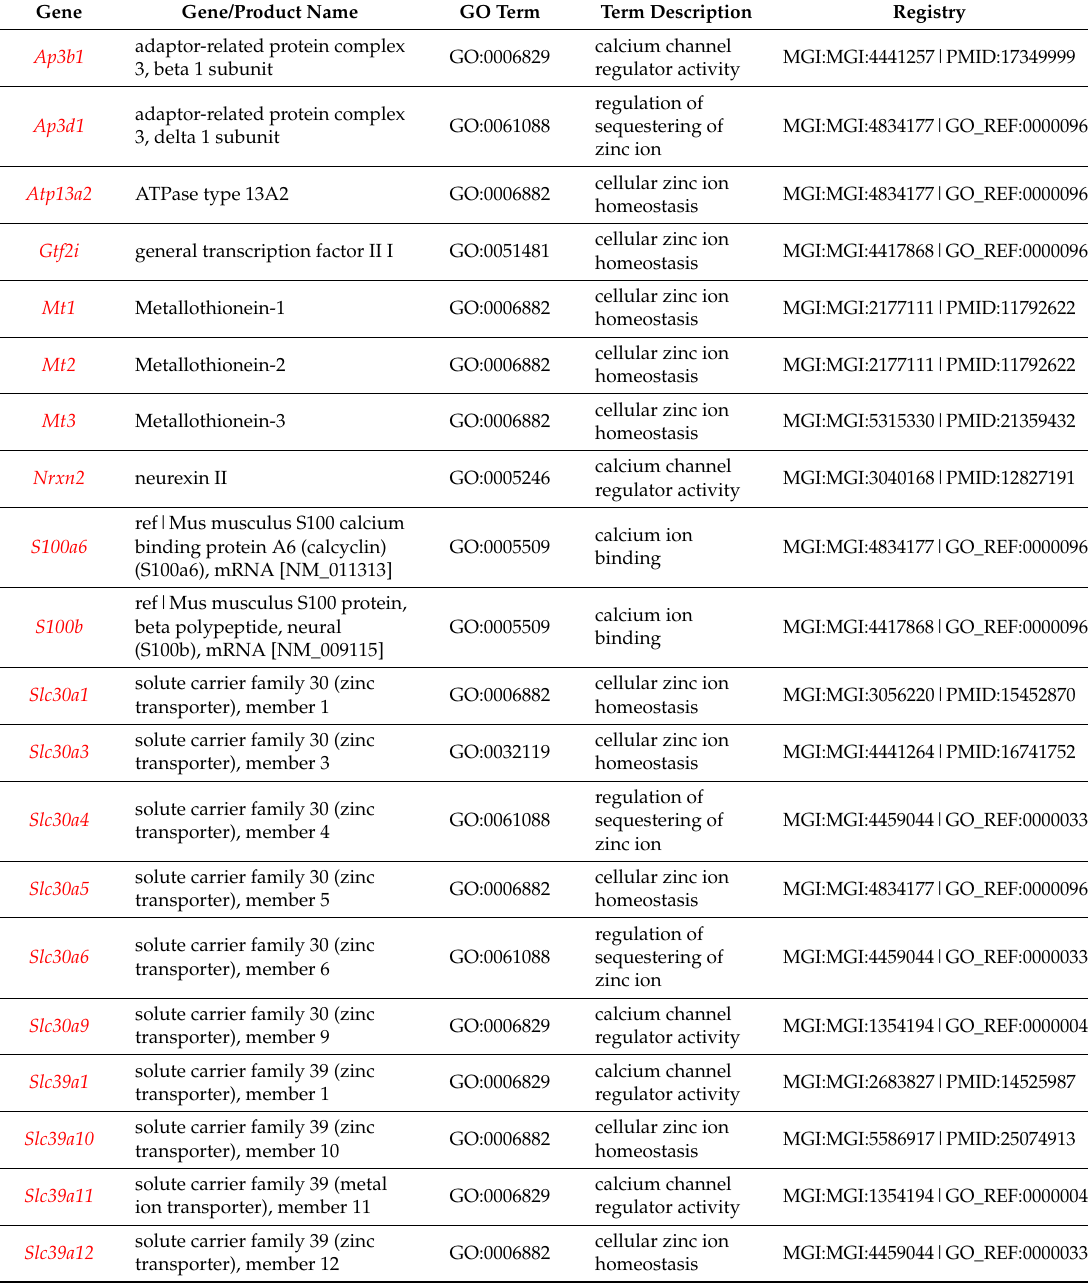
Table 1. Genes related to Zn ion homeostasis. Out of the 39 genes listed in Gene Ontology (GO) as associated with Zn ion homeostasis, 25 were expressed above background levels in the hippocampal dentate gyrus samples in this study (shown in